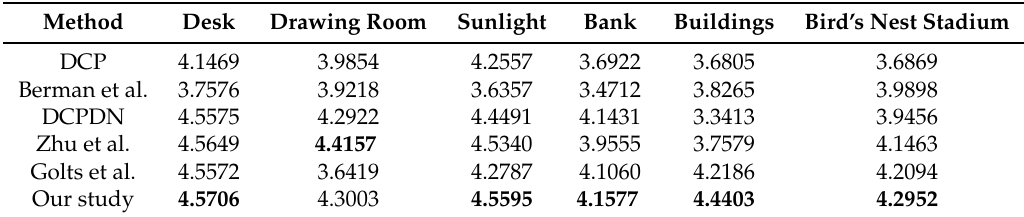
Table 3. Comparison of MOS of the dehazed images from Figures